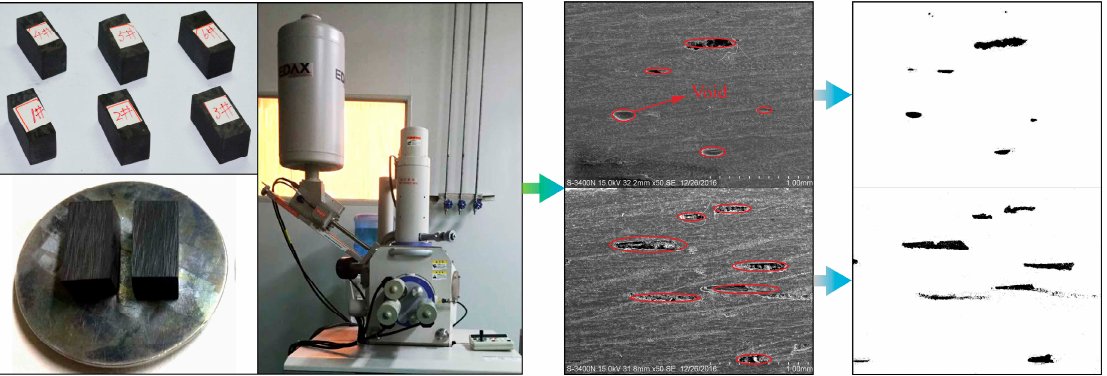
Figure 5. Process of measuring void content for composite tape winding products.